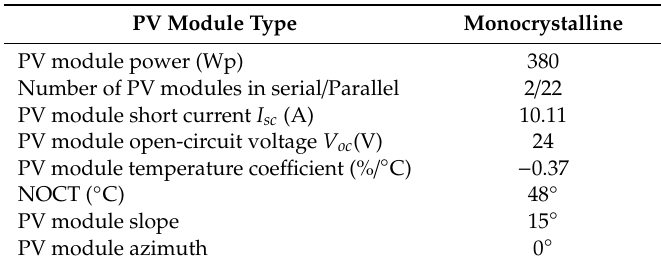
Table 2. Photovoltaic (PV) data of the simulated microgrid.